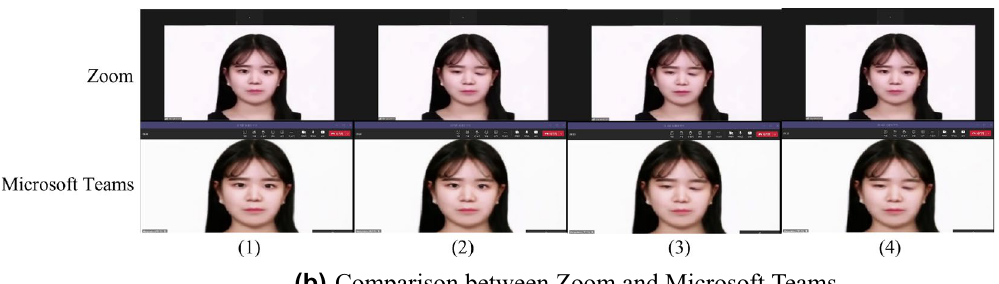
(b) Comparison between Zoom and Microsoft Teams. Figure 11. Comparison of expression swapping demonstration on Zoom, Google Meet, and Microsoft